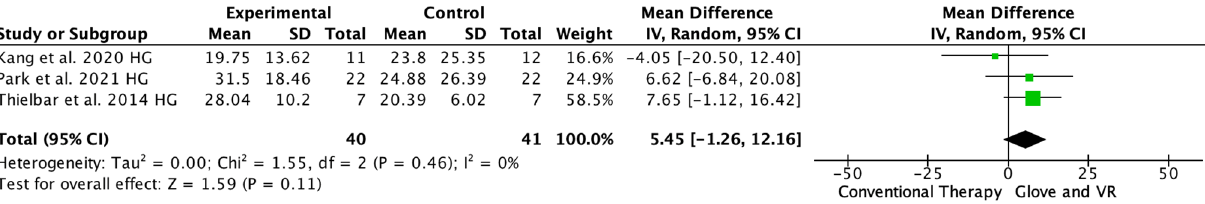
Figure 6. Forest plot of the results of a random effects meta-analysis on hand grip strength, shown as standardized mean differences (SMD) with 95% confidence interval (CI). The shaded square represents the point estimate for each individual study and the weight of the study in the meta-analysis. The diamond represents the overall mean difference of the studies [18,20,24].